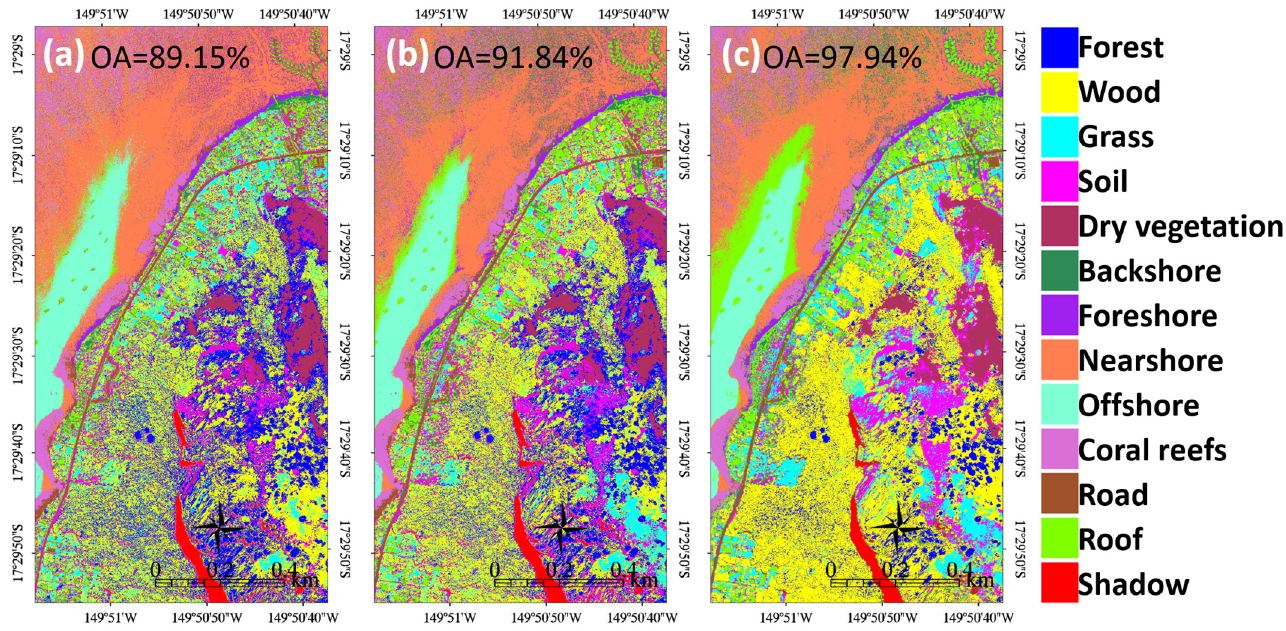
Figure 5. Maximum likelihood classification maps of the land-sea coral reefscape using WorldView-3: ( a ) basic dataset (blue-green-red); ( b ) visible dataset (Coastal-blue-green-yellow-red); ( c ) optical dataset (Coastal-blue-green-yellow-red-Red Edge-Near-InfraRed1-Near-InfraRed2).